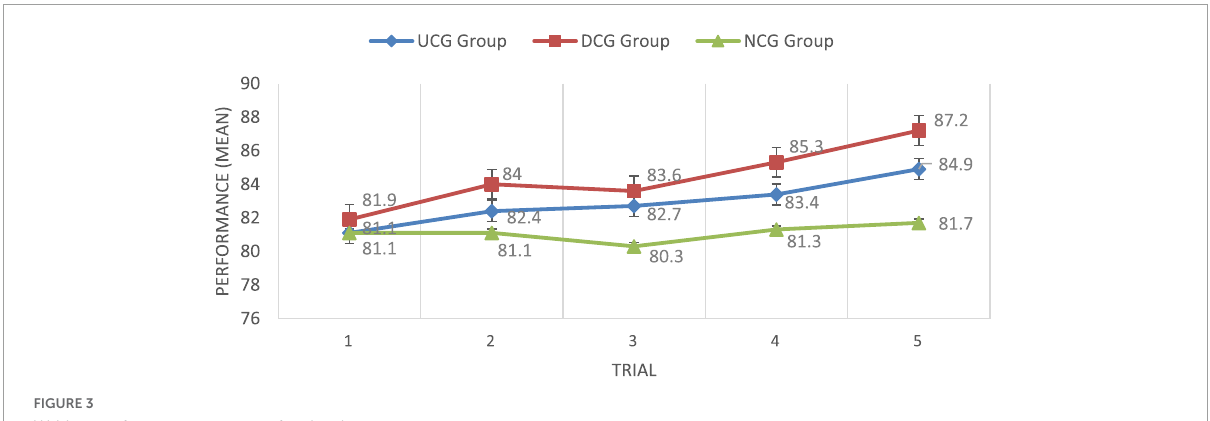
FIGURE3 Writing performance progress for the three groups.